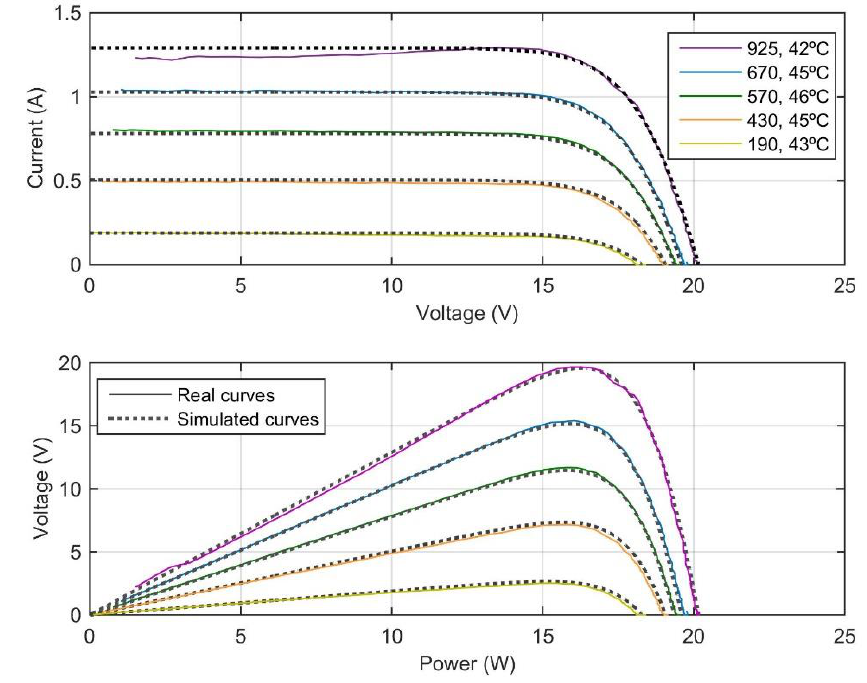
Figure 2. I-V and P-V characteristic curves of a PV module.